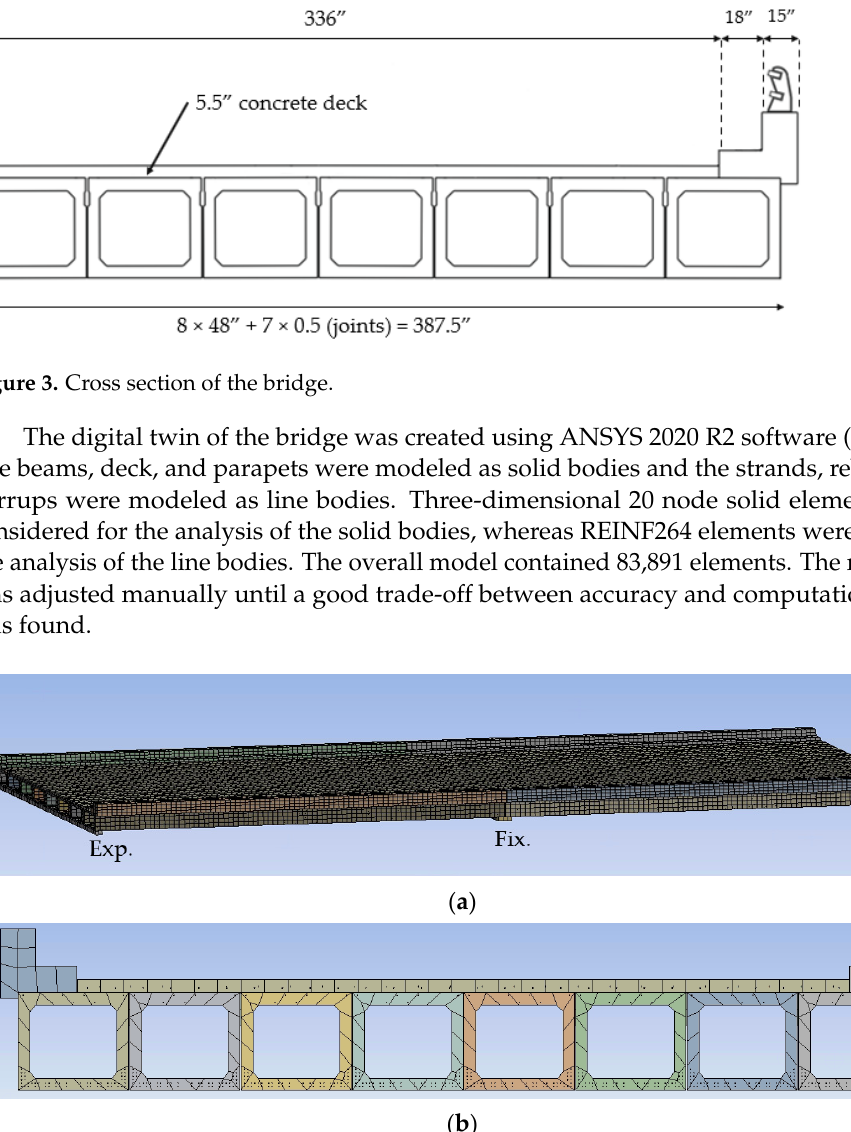
Figure 2. Cross section of the concrete box beams.